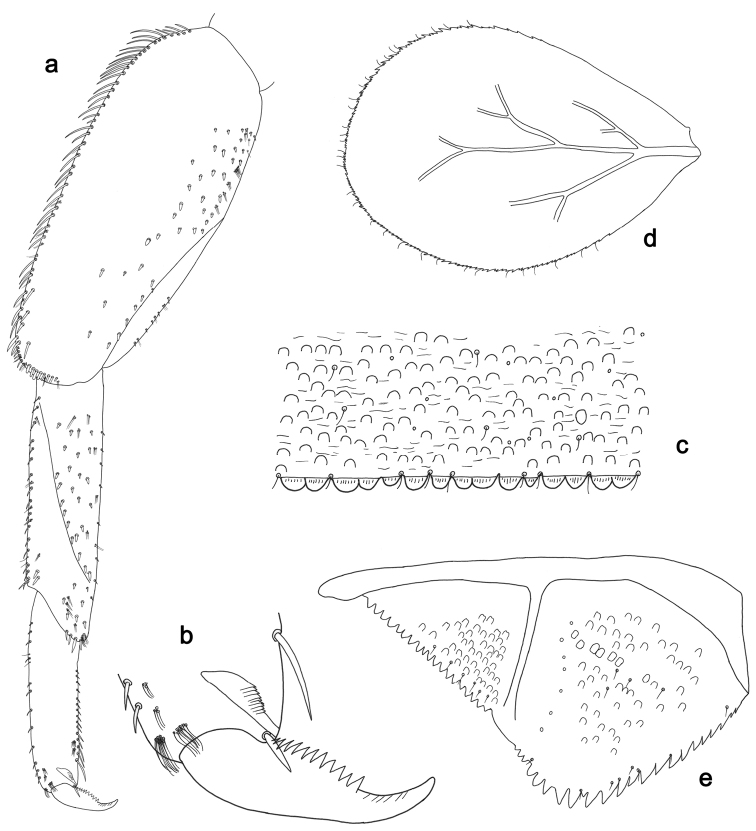
Labiobaetisgladius sp. n., larva morphology: aForelegb Fore claw cTergum IV d Gill IV eParaproct.